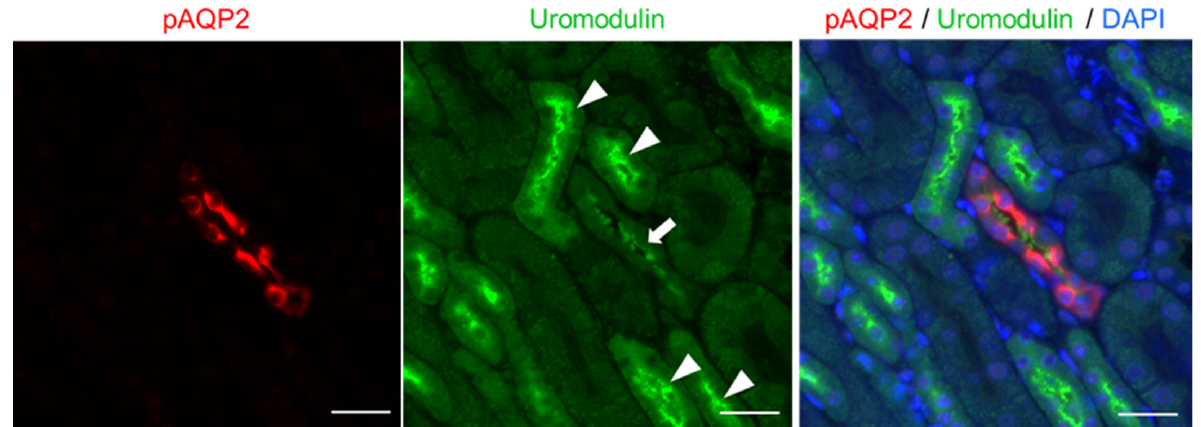
Figure 3. Uromodulin signals detected at the apical surface of the collecting duct. Representative immunofluorescence images for Ser256 − phosphorylated AQP2 ( red ), uromodulin ( green ), and merged image with 4 ′ ,6 − diamidino − 2 − phenylindole (DAPI) ( blue ) on Carnoy’s solution − fixed kidney sections from a wild − type mouse deprived of water for 24 h. Apical and cytosolic uromodulin signals were observed in the thick ascending limb of the loop of Henle (arrowheads). Uromodulin signals can be detected at the apical surface of the collecting duct (arrow). The scale bar indicates 20 µm.